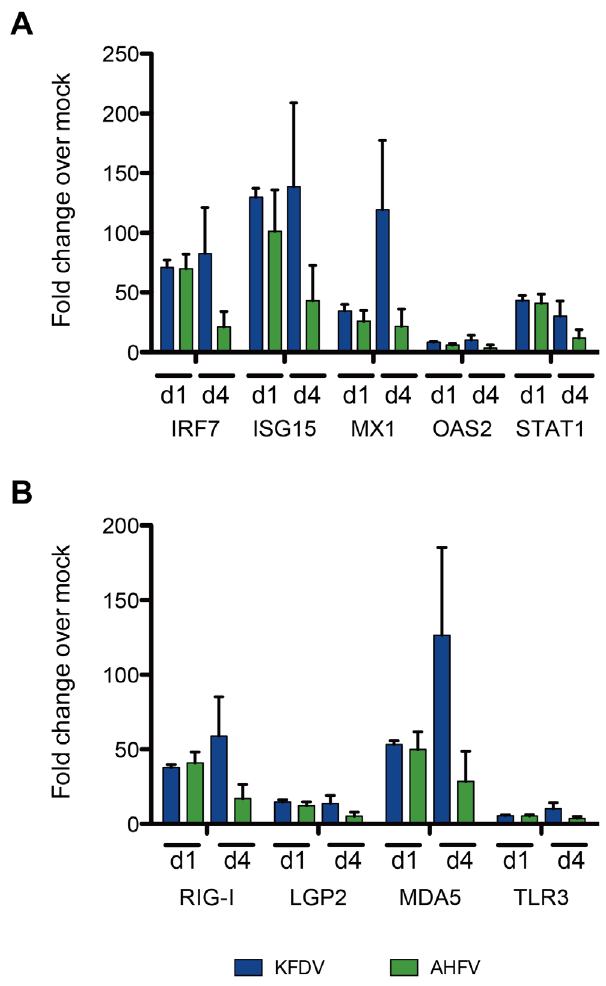
Figure 5. KFDV- and AHFV-infected mice mount an early innate response to infection in the CNS. In the brains of mice infected with KFDV or AHFV, there was significant upregulation of (A) interferon- stimulated genes and (B) pathogen recognition receptors (PRRs). There were not significant differences in gene expression between mice infected with AHFV and those infected with KFDV (n=5; p . 0.05).